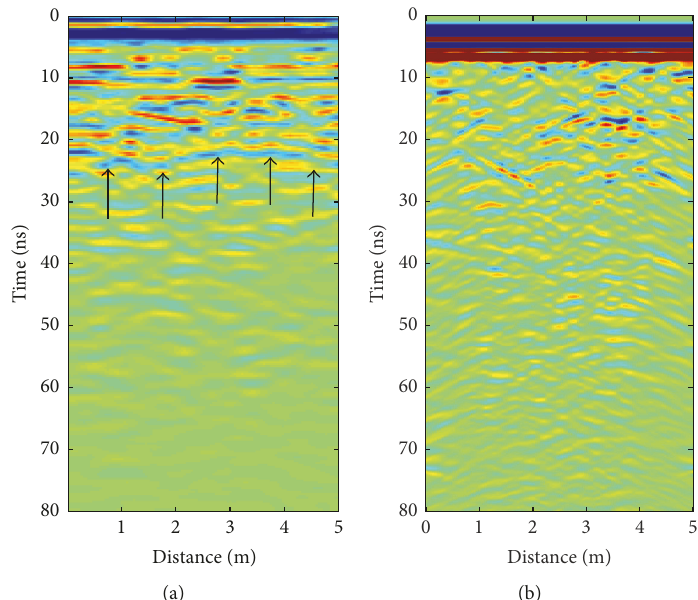
Figure 6: B-Scan of the LPR data (a) and the simulated data (b) of the heterogeneous random medium model (b).